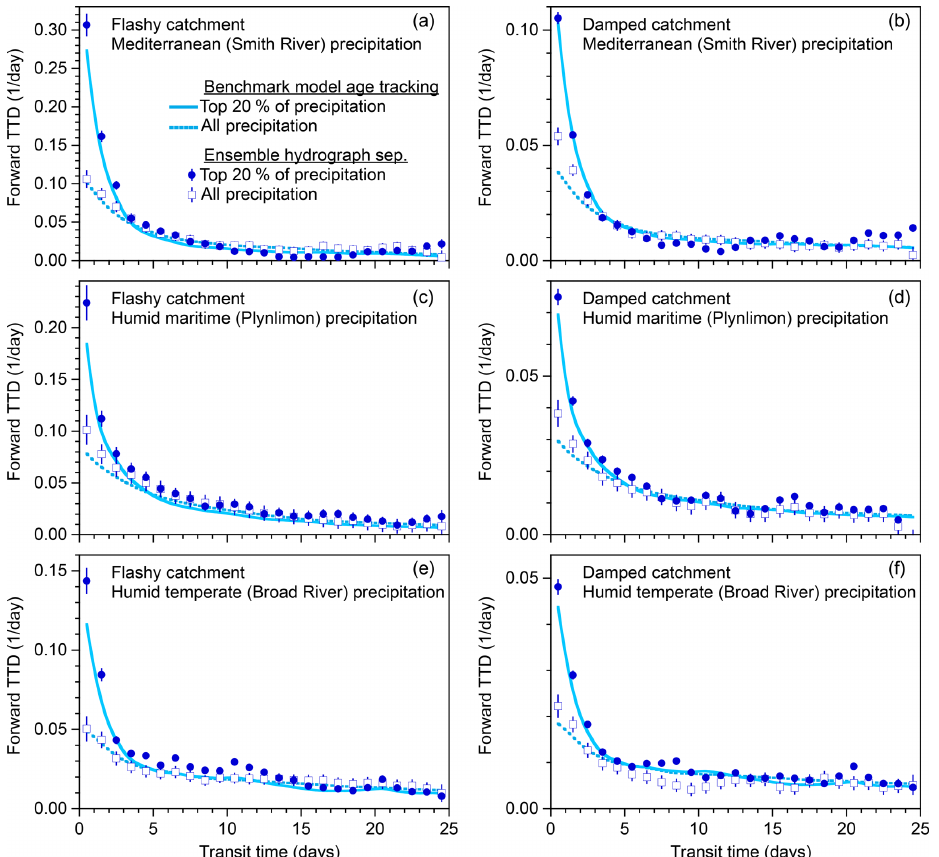
Figure 17. Forward transit time distributions P TTD k for intense precipitation (the highest 20% of daily precipitation totals; solid curve and solid circles), compared to forward transit time distributions for all precipitation (dashed curve and open squares). Solid circles and open squares show P TTD k estimates from ensemble hydrograph separation (Eq. 63); solid and dashed curves show the true P TTD k determined by age tracking in the benchmark model. Panels (a, c, e) and (b, d, f) show TTDs for flashy and damped catchments, respectively; the three rows of panels represent three different precipitation drivers. Note that vertical axis scales differ greatly. Despite a tendency for ensemble hydrograph separation to over-predict P TTD k for short lag times, the differences between the ensemble hydrograph separation estimates for intense precipitation and normal precipitation (open squares and solid circles) closely mirror the differences between the solid and dashed curves. Thus ensemble hydrograph separation can estimate the relative effect of intense precipitation on forward transit times, across widely differing precipitation drivers and catchment